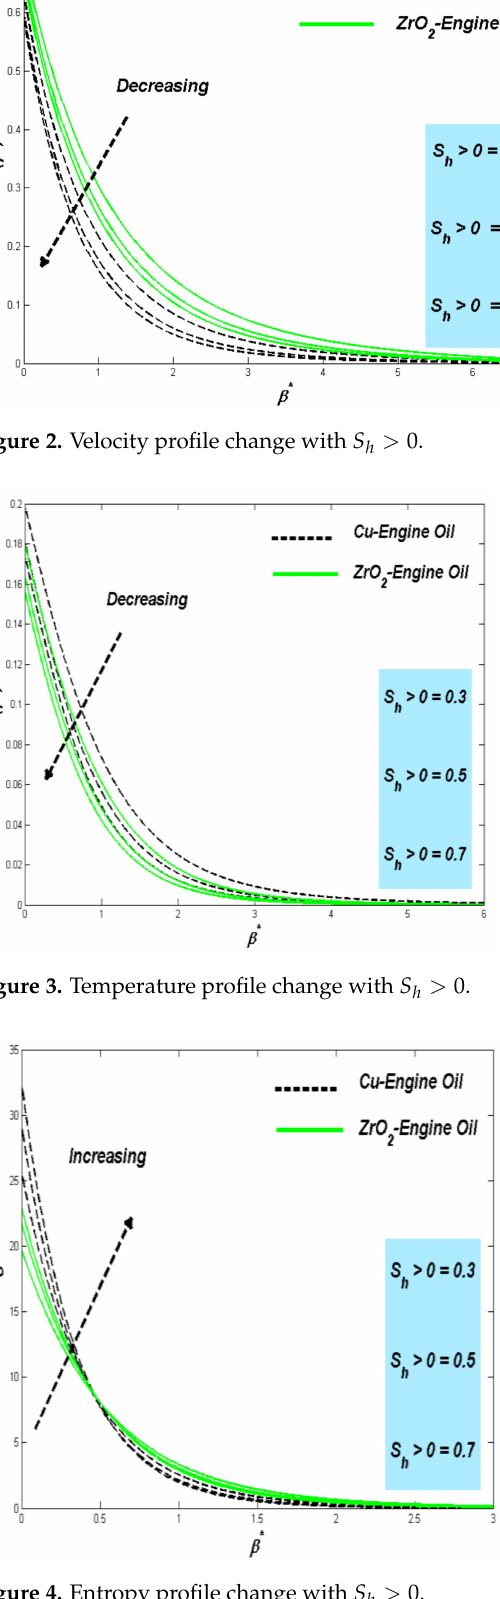
Figure 4. Entropy profile change with S h >